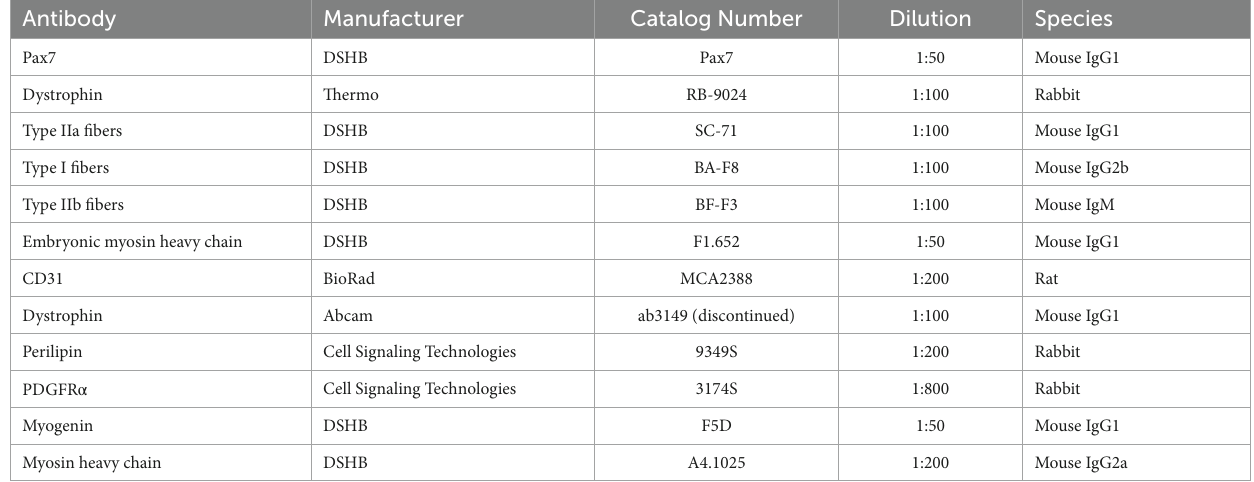
TABLE 1 Commercially available antibodies used for immunofluorescence